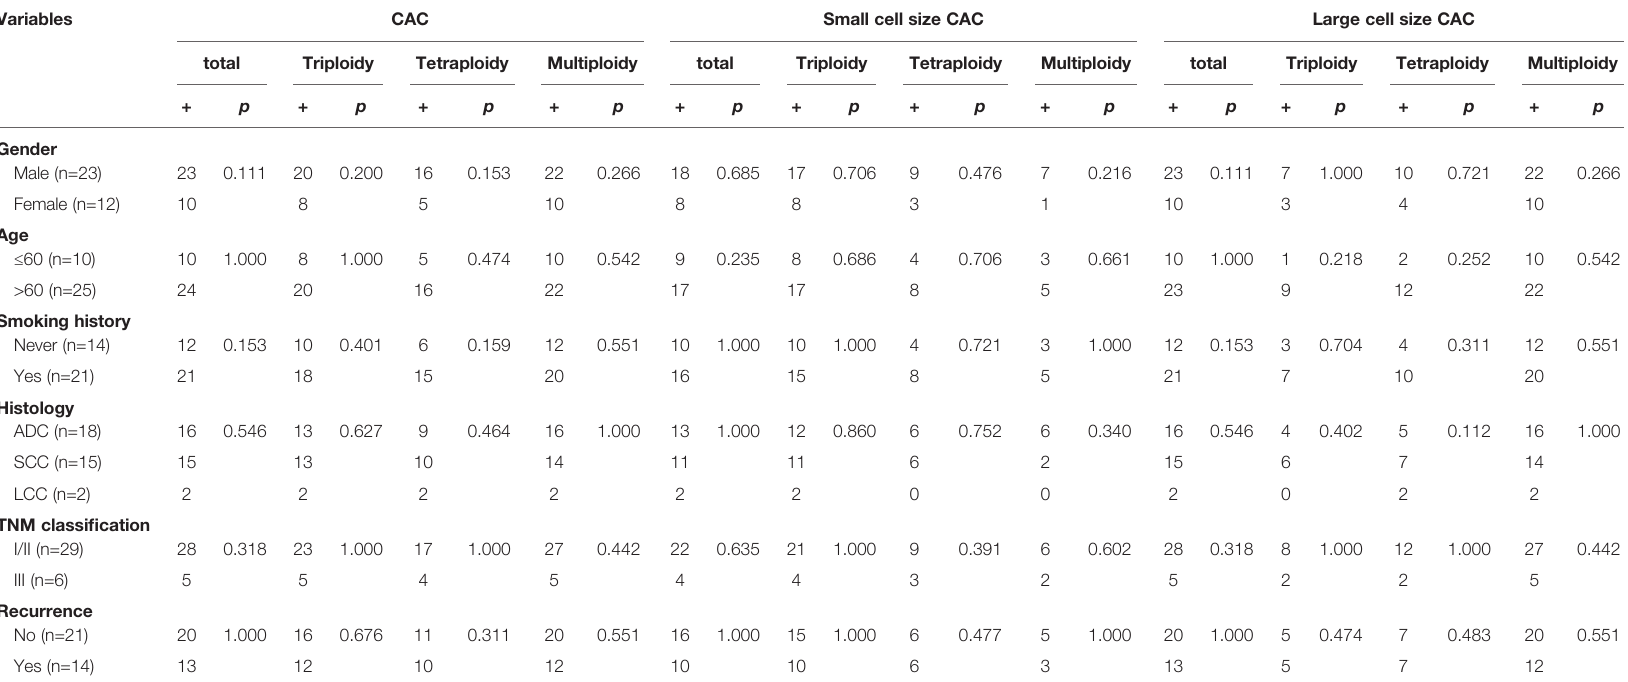
TABLE 5 | Correlation of post-surgery CAC to clinical characteristics